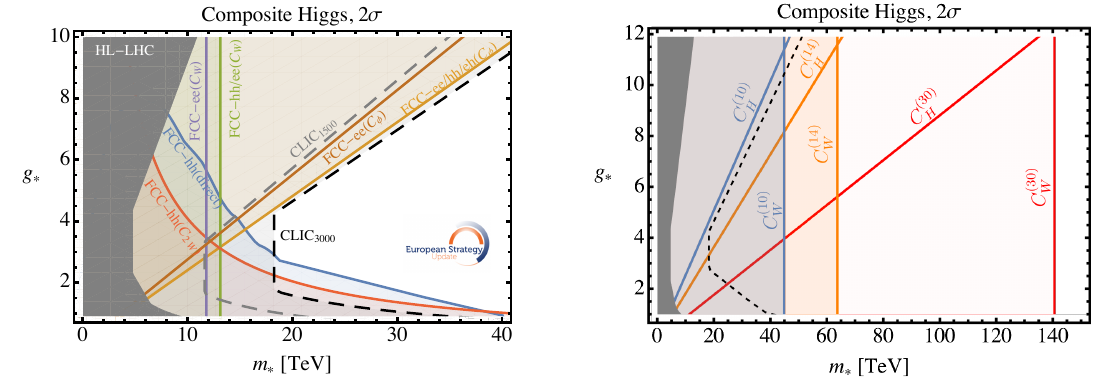
Figure 8 . Left: 2 σ sensitivity of future collider projects to Higgs compositeness, from ref. [13]. Right: the VHEL projections based on the sensitivity to C H in table 8 and to C W (single operator reach) from the “Combined” fit (which excludes polarized measurements) in table